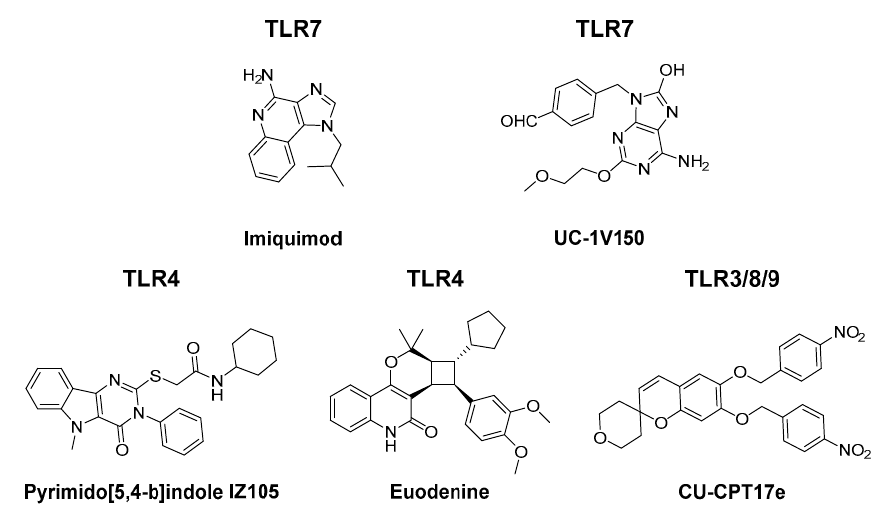
Figure 3. Structure of small molecule TLR agonists with potential TAM reprogramming abilities.